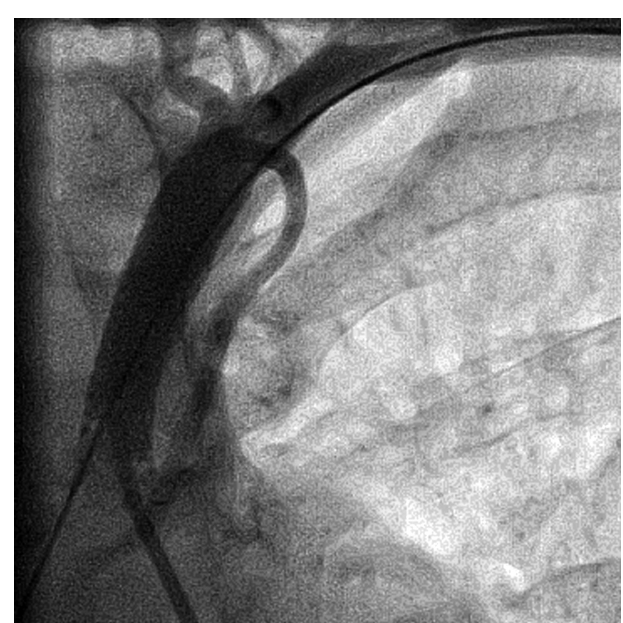
Fig. 4 - Filling anterograde left subclavian artery and the proximal third of the left internal thoracic